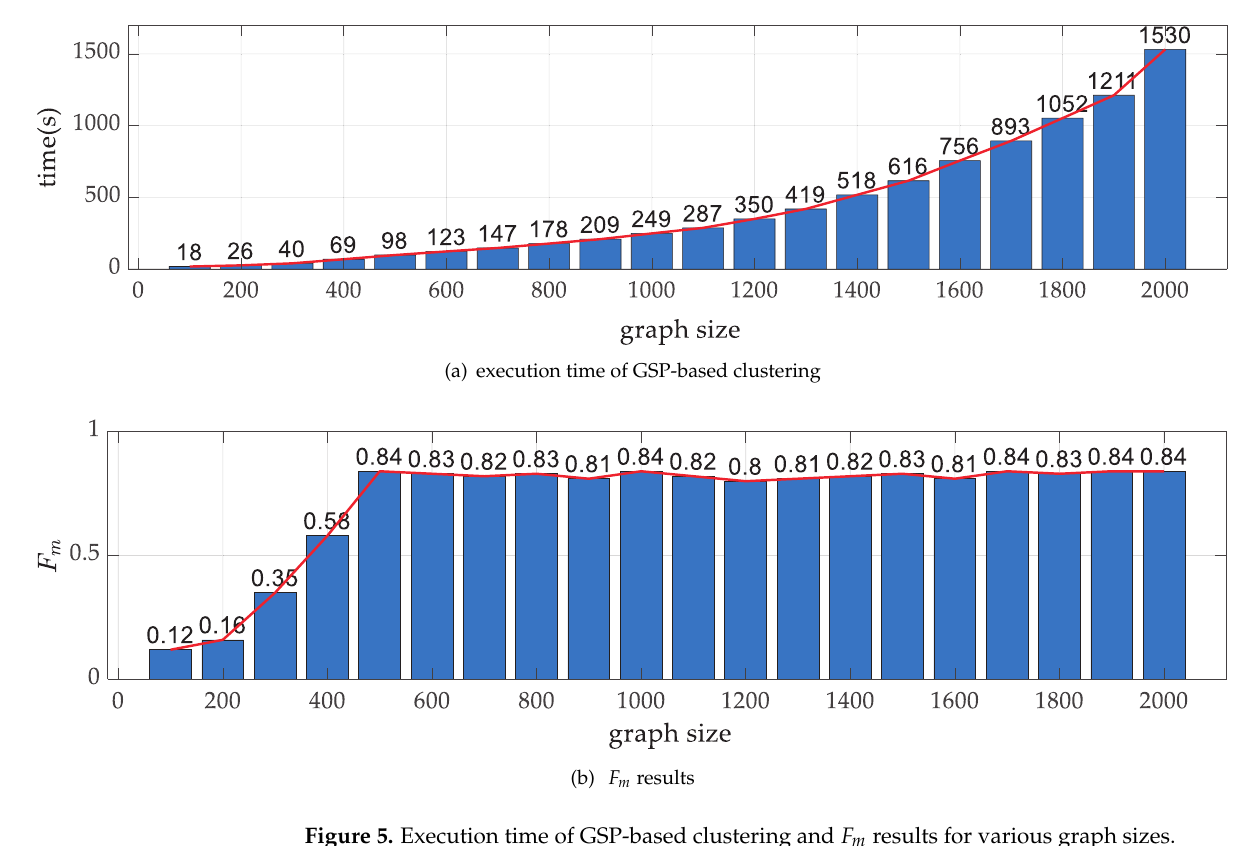
Figure 5. Execution time of GSP-based clustering and F m results for various graph sizes.